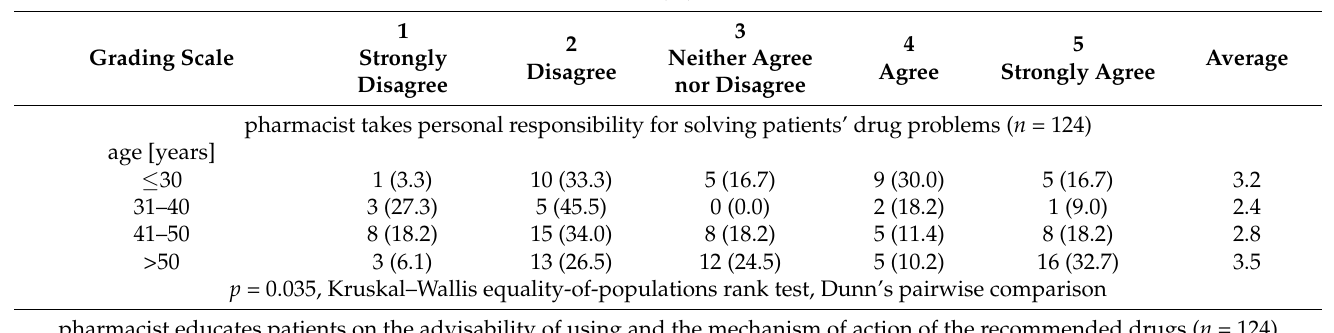
Table 4. Nurses’ current experience in the field of cooperation with a pharmacist in detail. Characteristics of